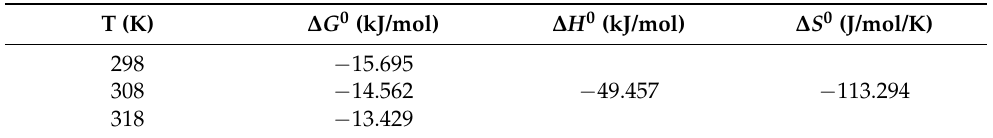
Table 4. Thermodynamic parameters of Cr (VI) removal by S-nZVI@OS at different temperatures (298, 308, 318 K).